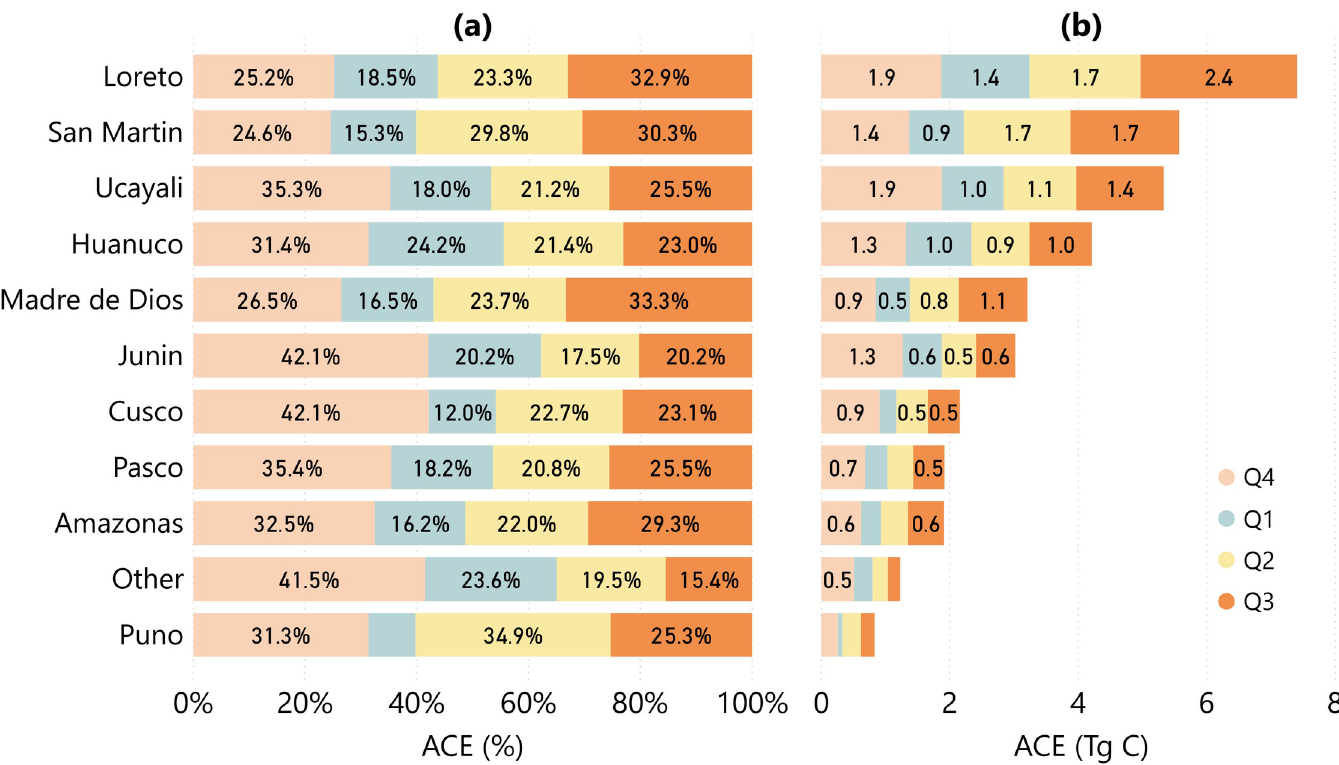
Fig 4. Quarterly ACE statistics at regional level. (a) Yearly distribution of quarterly ACE statistics for all legal regions in Peru and (b) the quarterly ACE values for these regions (Tg C), between Q4 of 2017 and Q3 of 2018.